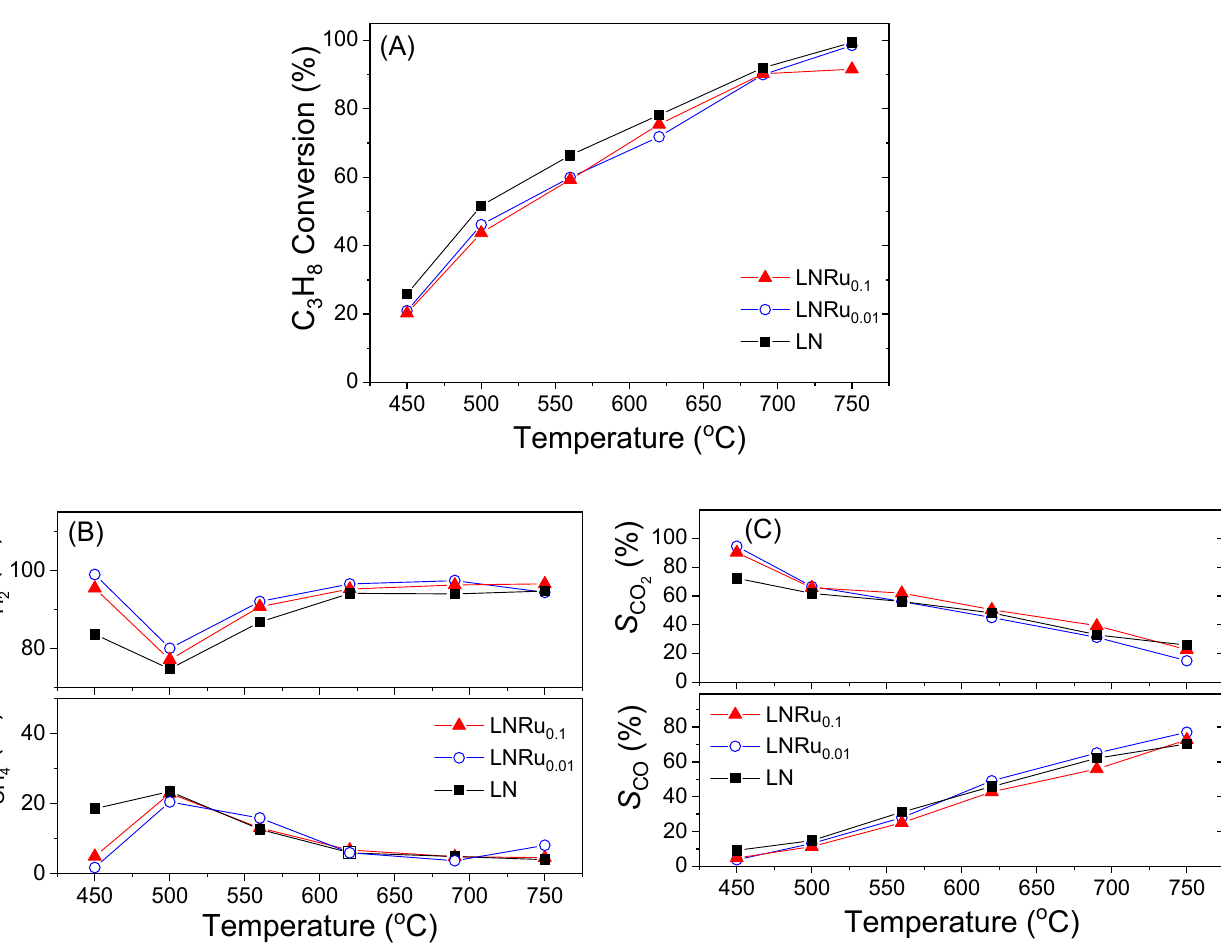
Figure 4. ( A ) Conversion of propane, ( B ) selectivities to H 2 and CH 4 , and ( C ) selectivities to CO 2 and CO obtained over the LNRu x catalysts. Experimental conditions: same as in Figure 3.